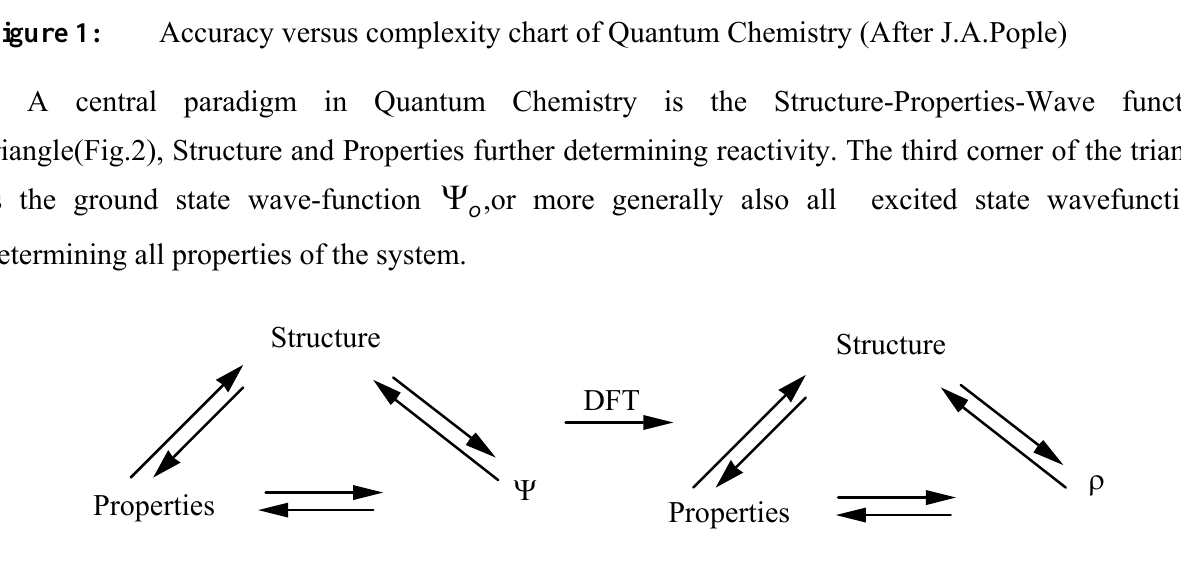
Figure 2 : The central paradigm in Quantum Chemistry and its evolution upon the introduction of DFT